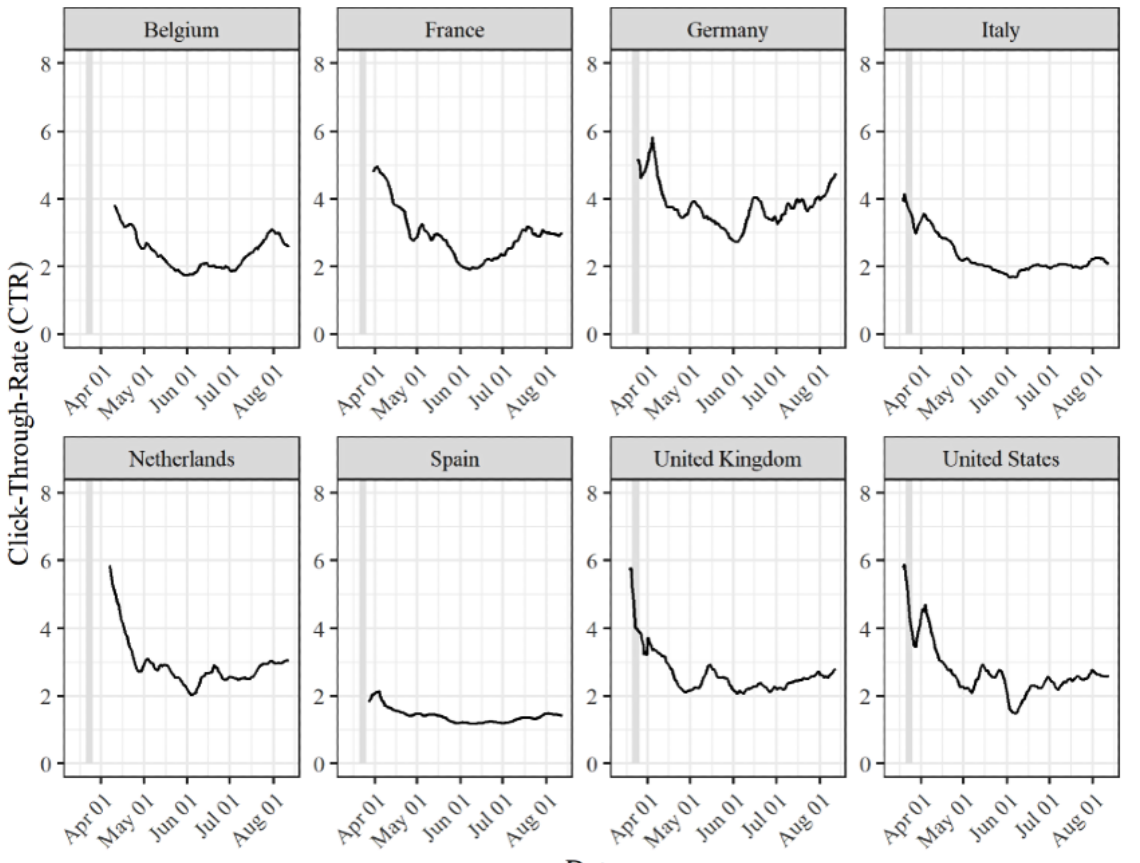
Figure 4. CTRs between March 13 and August 12, 2020 across the 8 countries. The line shows the 7-day moving average. The shaded area shows the period during which technical problems with ad delivery occurred. CTR: click-through